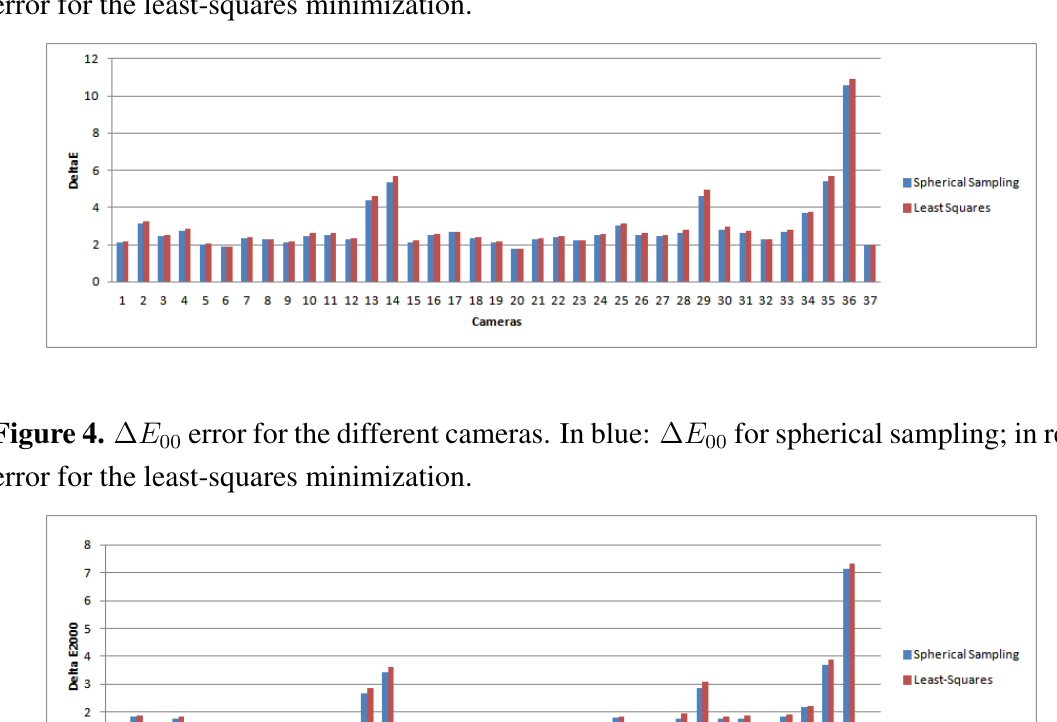
Figure 3. ∆ E error for the different cameras. In blue: ∆ E for spherical sampling; in red: error for the least-squares minimization.